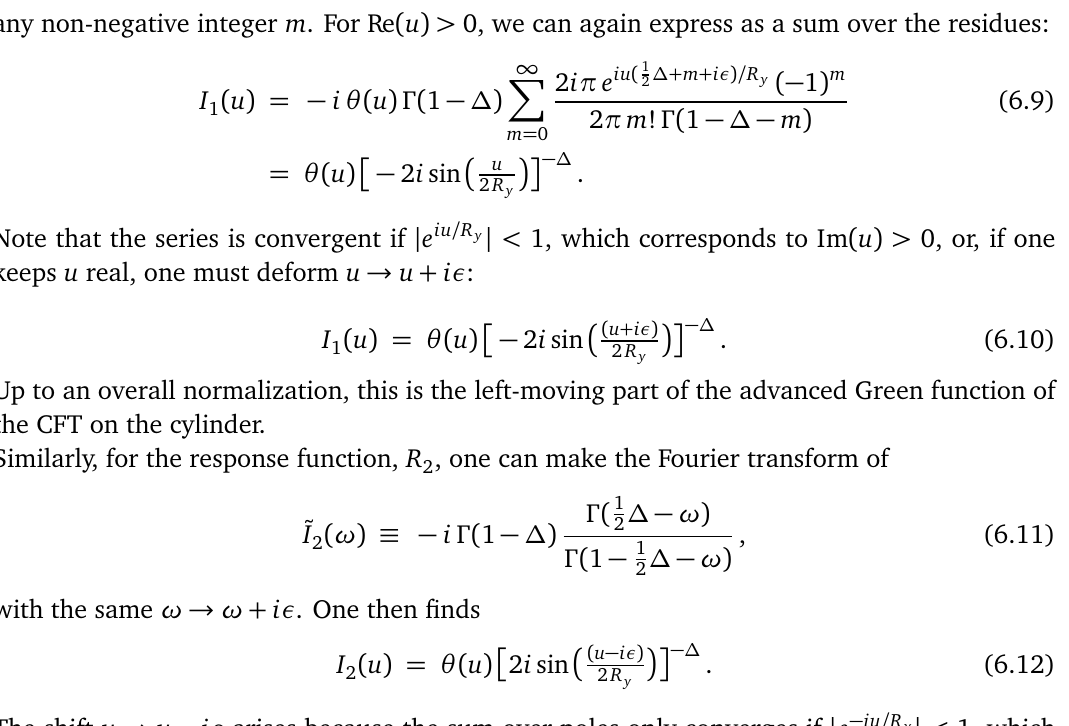
Figure 12: Logarithmic plot of the two-point function (6.4) in the v -direction with / 20 held constant. The left-moving temperature is r H u = R y = π/ 40 for the dotted orange line. The exponential fall-off (linear blue line and r H R y on this plot) is visible at early times, as long as the m = 0 mode dominates the propagator. In this regime, the other modes appear only briefly as poles. For v larger than πβ , the behavior changes drastically. The propagator locally still behaves as L an exponential, but the enveloping curve is polynomial at long